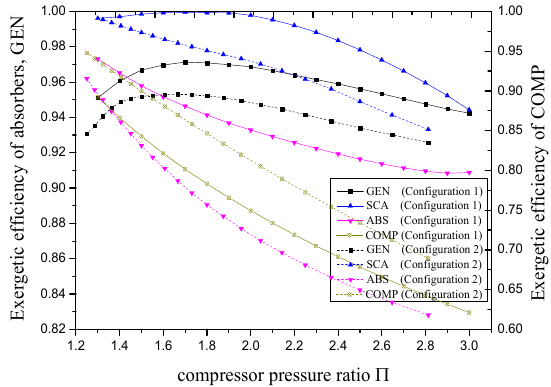
Figure 18. η of ABS, SCA, GEN, and COMP versus π at T GEN = 100 °C .